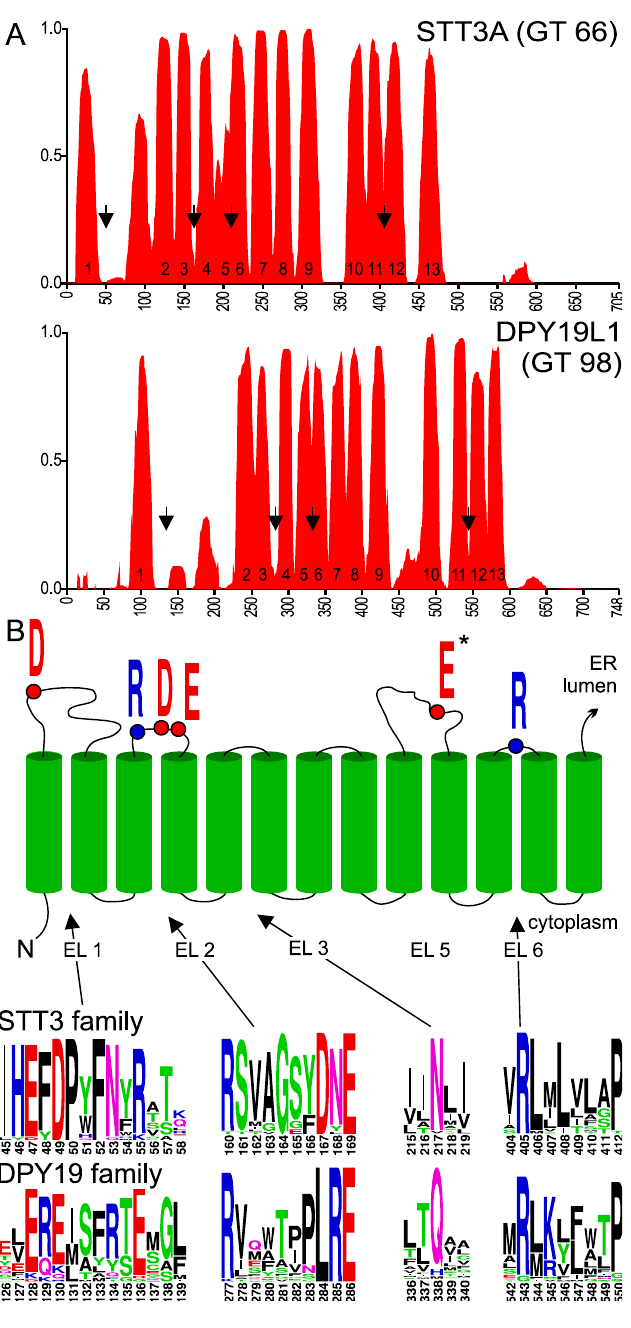
Figure 2. ( A ) Transmembrane probability of STT3A and DPY19L1. Transmembrane domain prediction was carried out using the algorithm PolyPhobius with a multiple alignment comprising 25 most diverse members of the two families, as described in experimental procedures. Proposed transmembrane domain (TMD) numbering is based on the structure of bacterial Campylobacter lari oligosaccharyltransferase [21]. ( B ) Upper panel: Conserved residues involved in catalysis in STT3. Lower panel: Conserved areas (arrows in Figure 2A) in extracytoplasmic (luminal) loops (EL) of the STT3 and DPY19 family. *E in EL5 is part of the catalytic pocket, but due to the large size of this loop and the presence of multiple D (aspartic acid) and E (glutamic acid) residues, no clear equivalent can be observed in DPY19 enzymes (see supplemental Figure S1A,B). The asparagine (N) in EL3 is highly conserved in STT3, but has not been associated with the catalytic pocket.